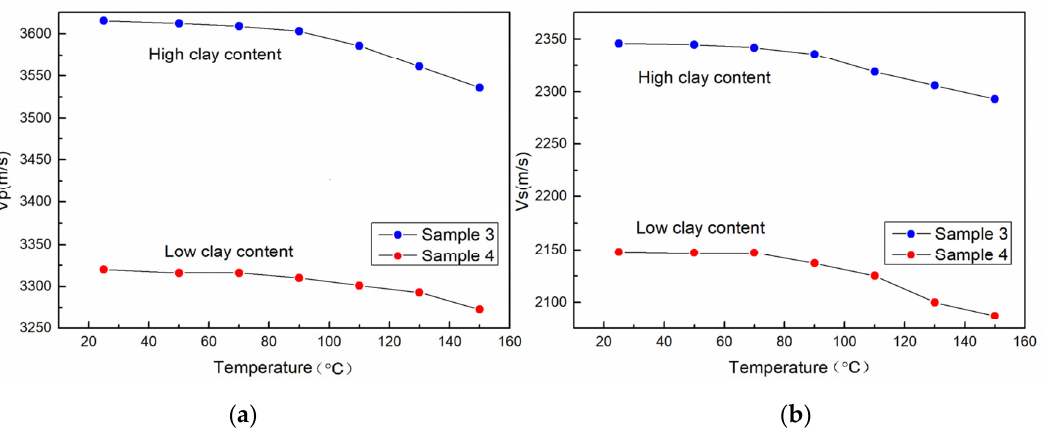
Figure 10. Cross-plot of temperature and ( a ) P- and ( b ) S-wave velocity.